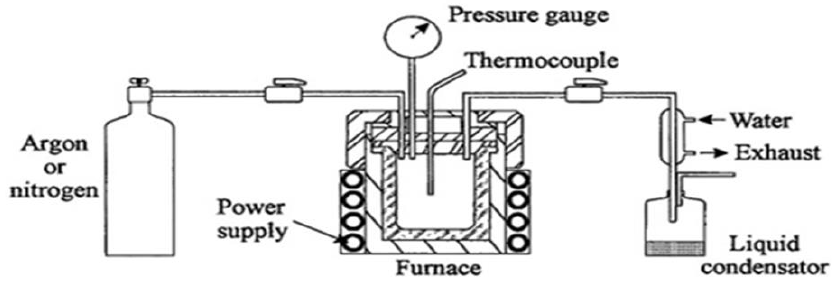
Figure 1. A pressurized vessel with a temperature controller unit [28].